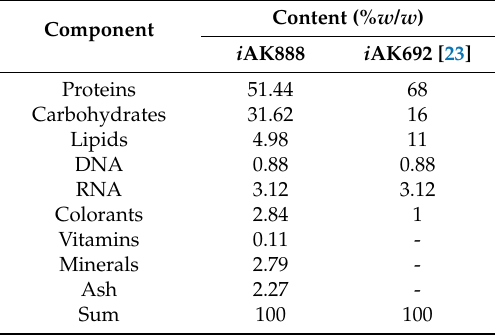
Table 1. Comparison of biomass constituents between i AK888 and i